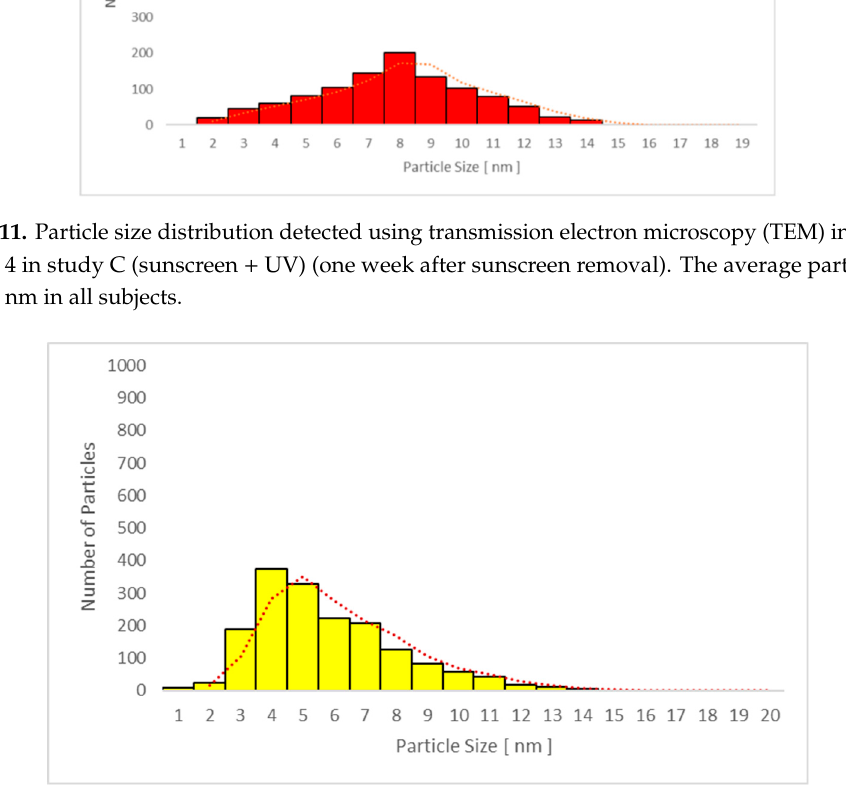
Figure 12. Particle size distribution determined by transmission electron microscopy (TEM) in urine sample 3 in study C (sunscreen + UV). The average particle size was 5.4 nm in all subjects.